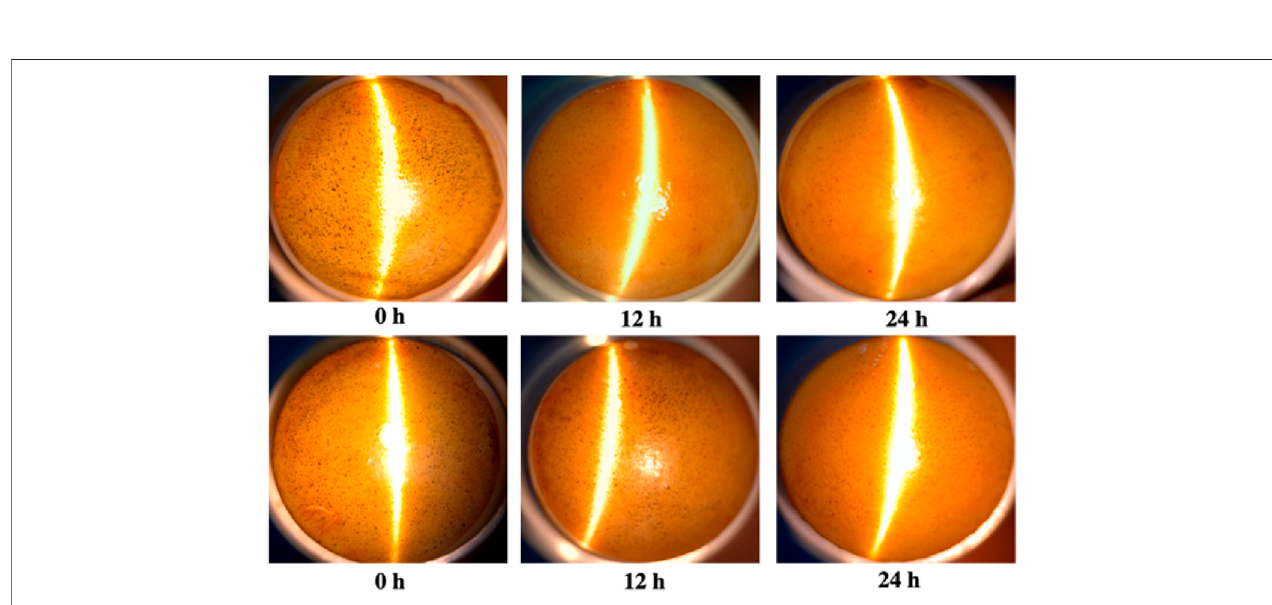
FIGURE 7 | In vitro degradation of epigallocatechin gallate loaded starch hydrogel/contact lens composites by alpha-amylase. The concentration of active alpha- amylase was 0.1 mg/ml (A) and 0.01 mg/ml (B) .